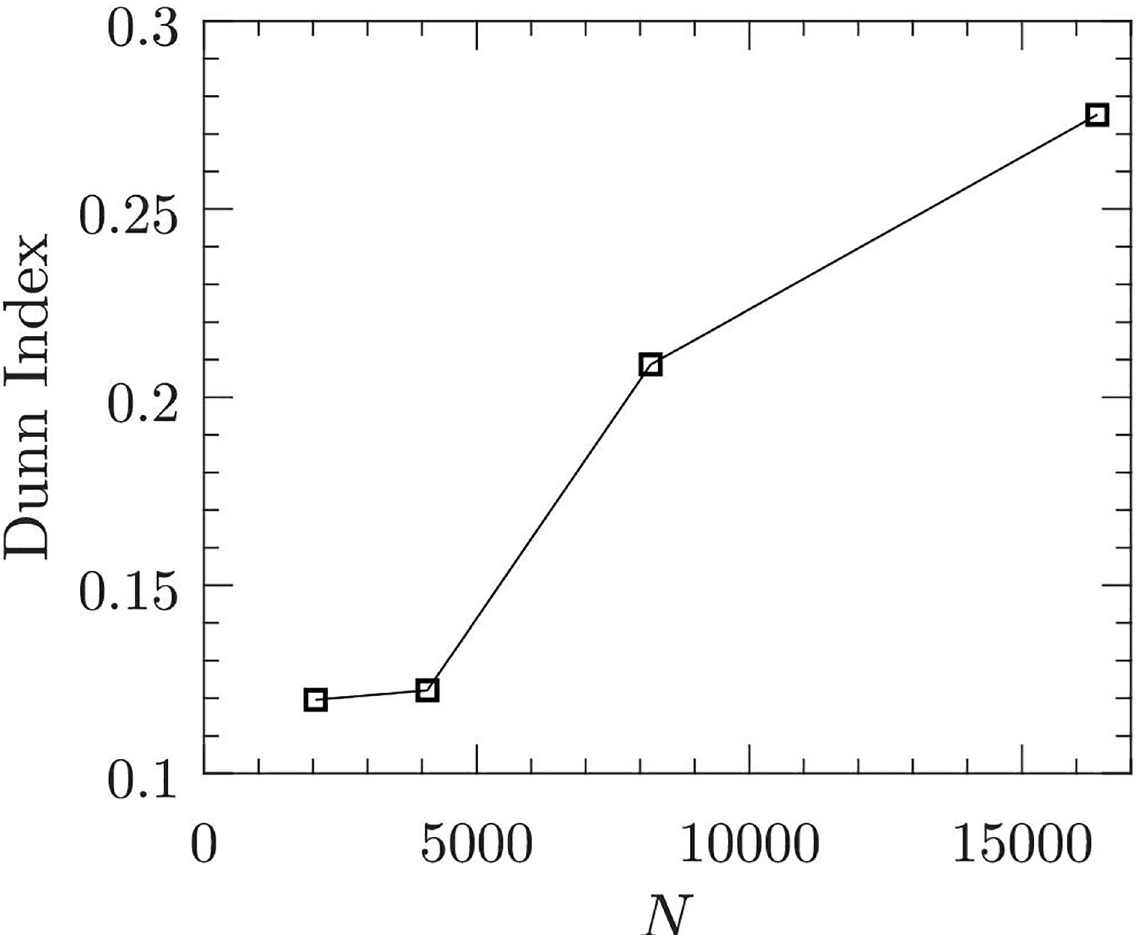
Fig 4. Effect of signal length N on Dunn Index. In this example, N = 2048, 4096, 8192, and 16384. In this case load = 45.35 kg (100 lb) and rotational speed = 25 rps (1500 rpm).